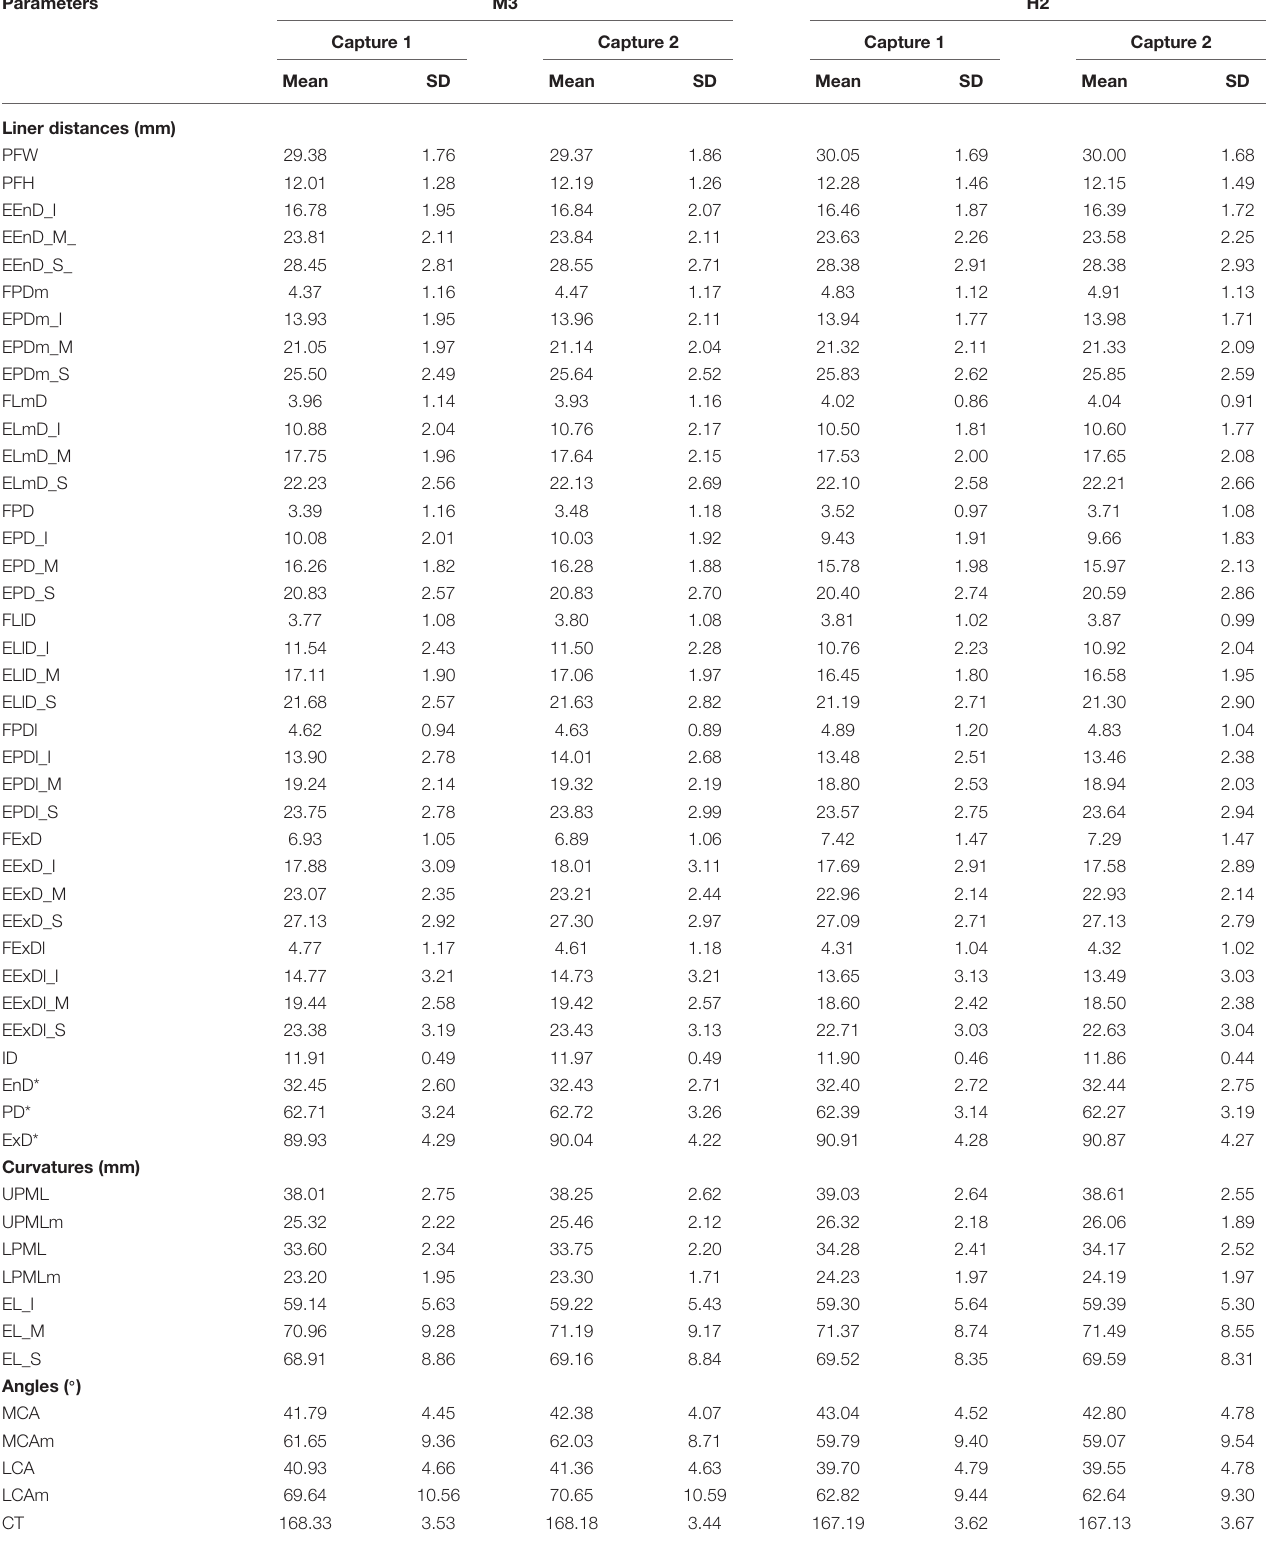
TABLE 3 | Means and standard deviations (SDs) of all measurements (mm or degrees). Parameters M3 H2 Capture 1 Capture